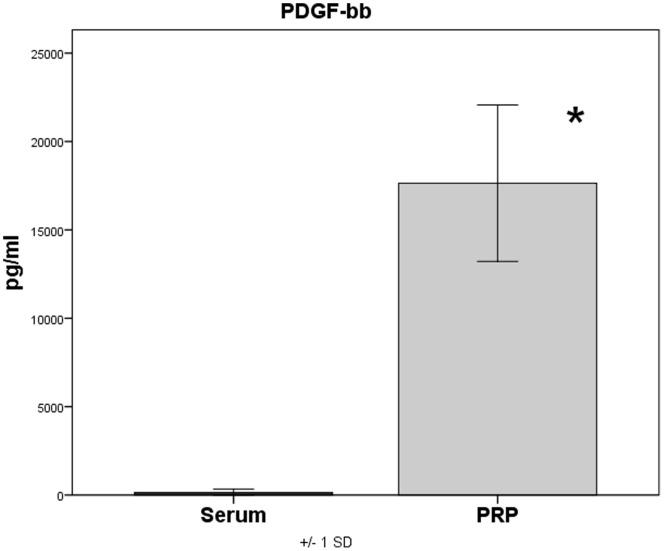
Quantification of PDGF-bb in serum and PRP, p<0.001 PRP versus serum.